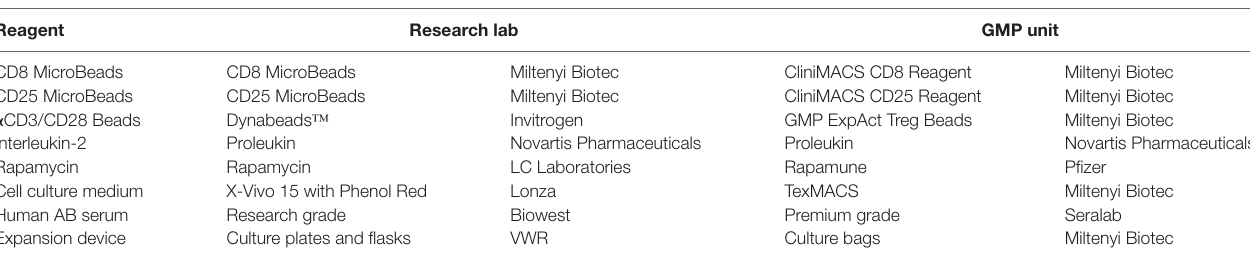
TAbLe 1 | Comparison of research- and GMP-grade reagents.